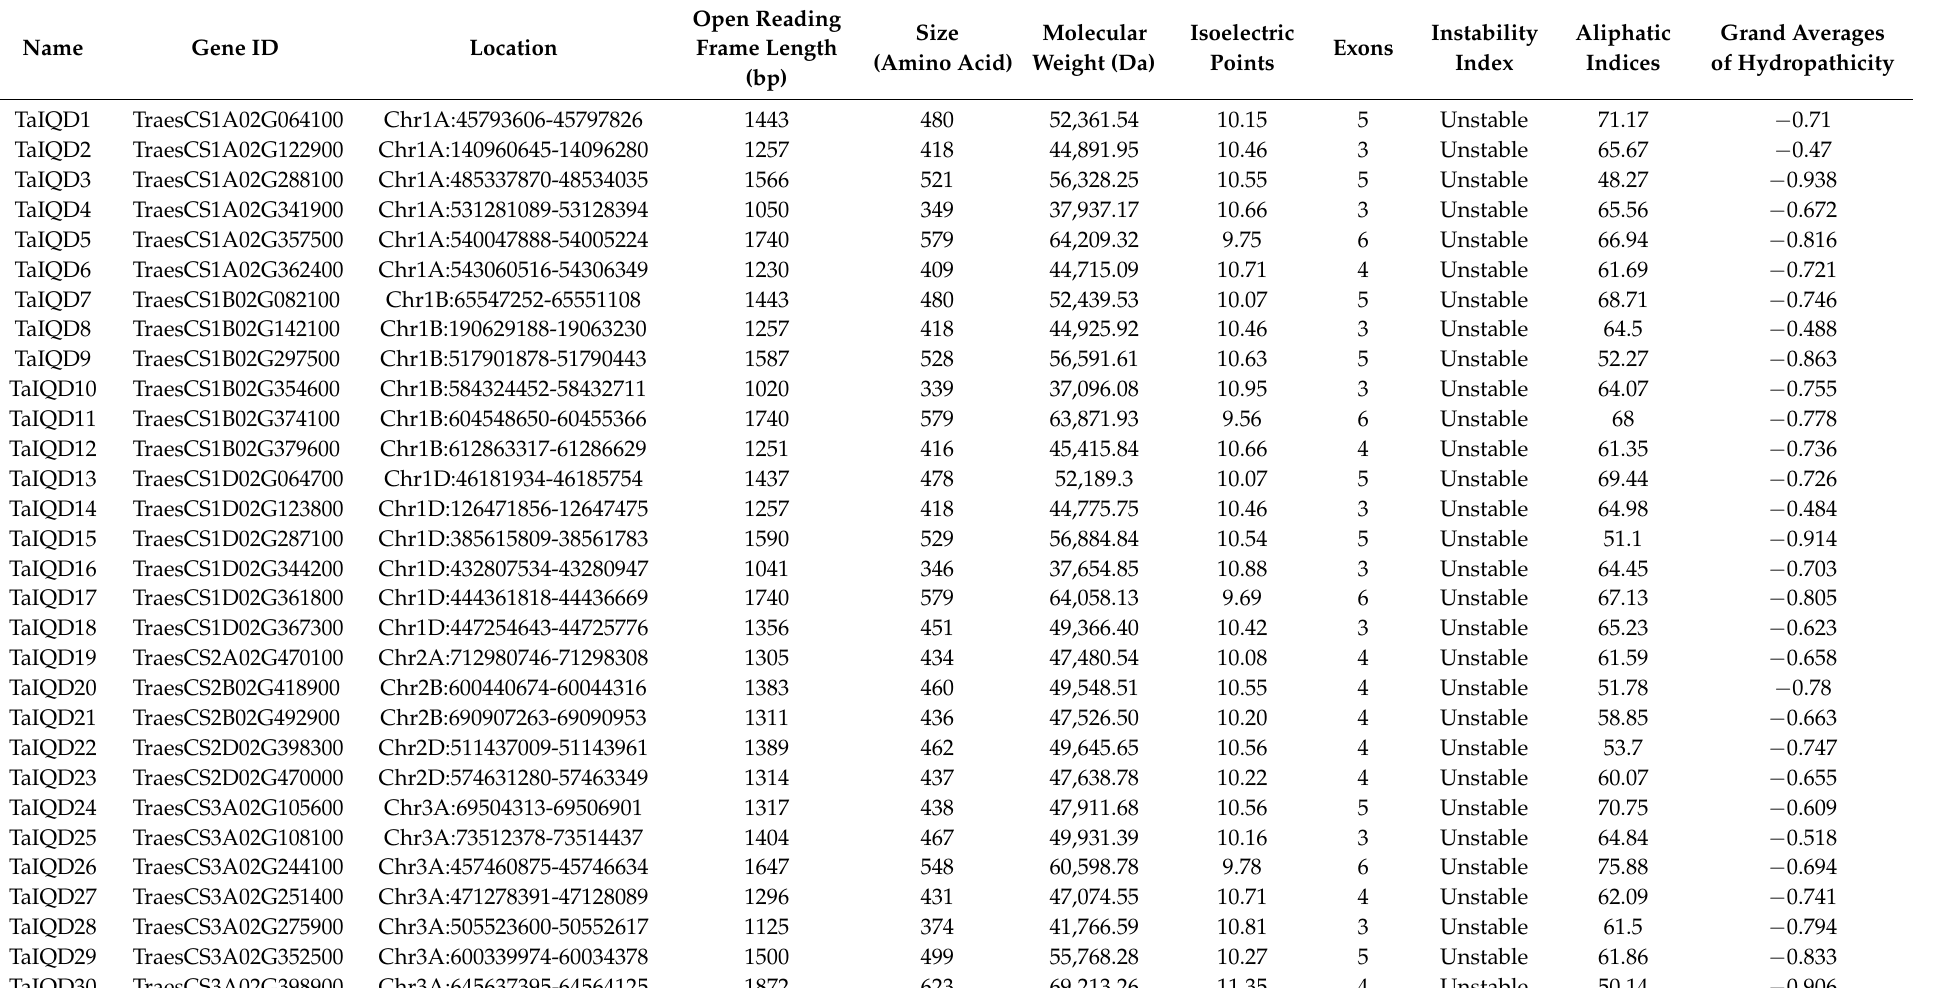
Table 1. Detailed information of the 73 predicted IQ67 domain (IQD) proteins in Triticum aestivum